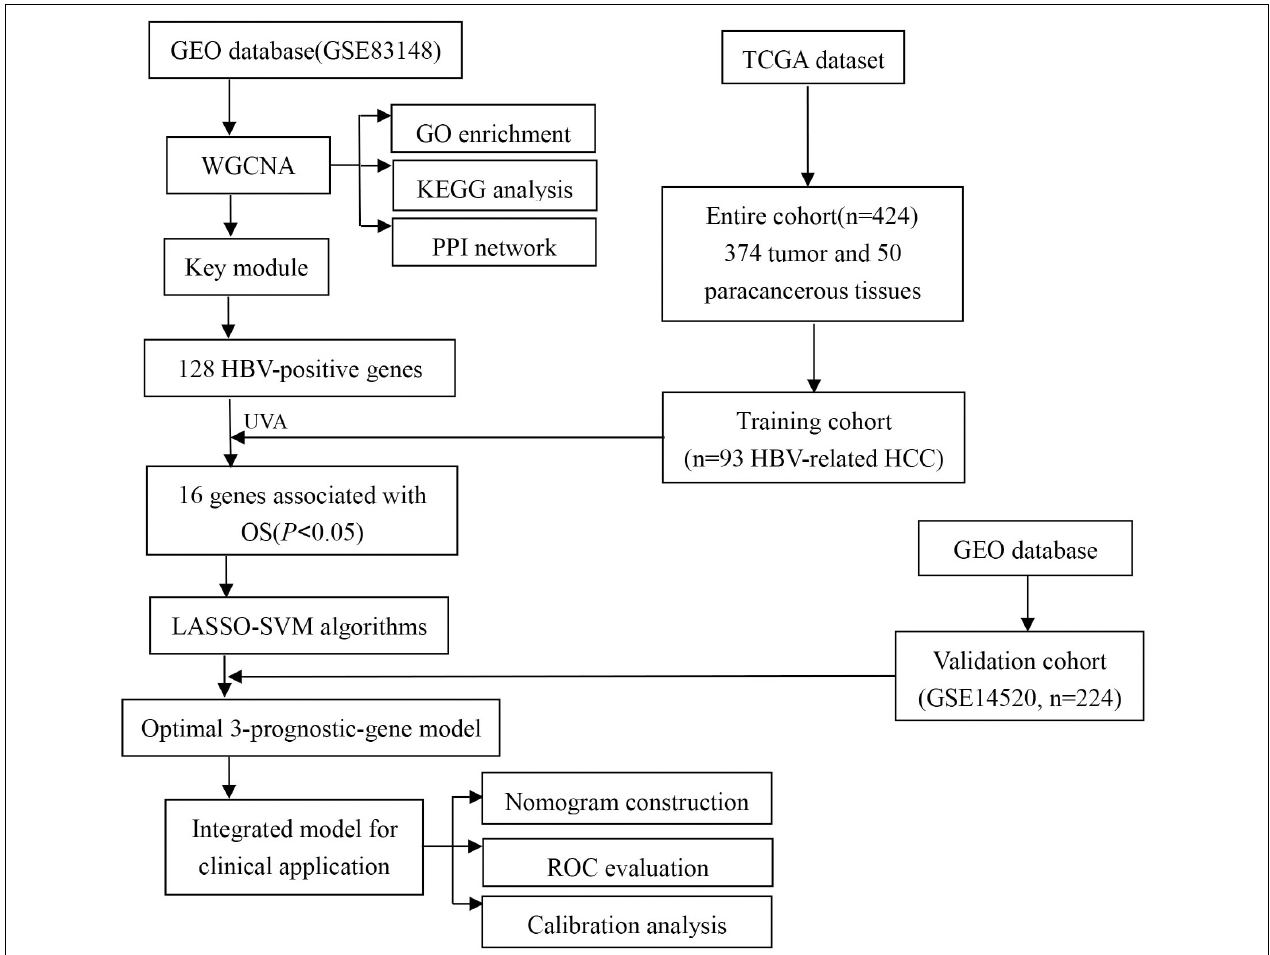
FIGURE 1 | The workflow of our